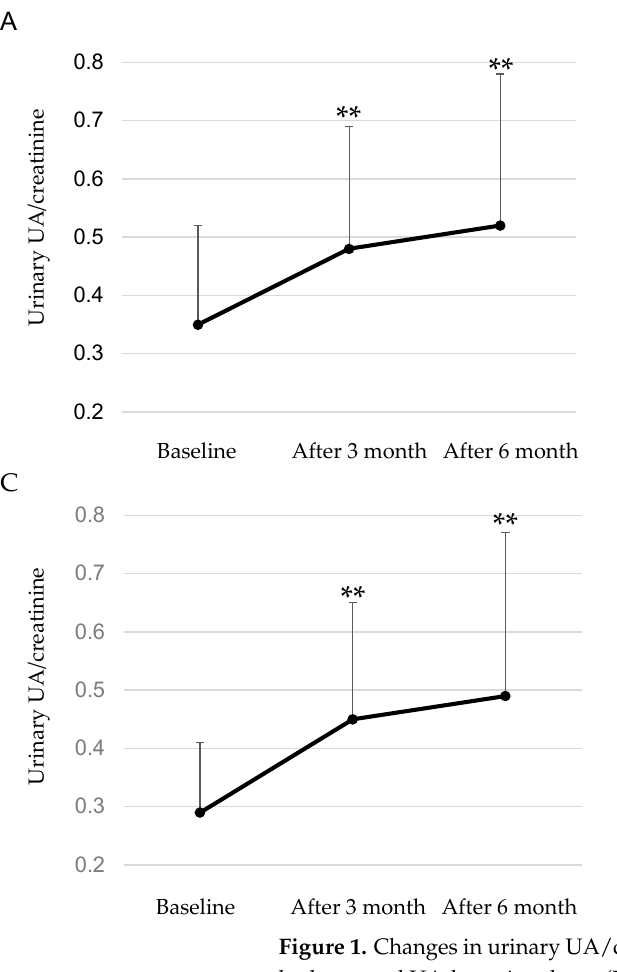
Figure 1. Changes in urinary UA/creatine after the start of dotinurad in all patients ( A ), patients who had not used UA-lowering drugs ( B ), and patients who switched from XO inhibitors ( C ). *, ** indicate p < 0.1 and p < 0.05, respectively.